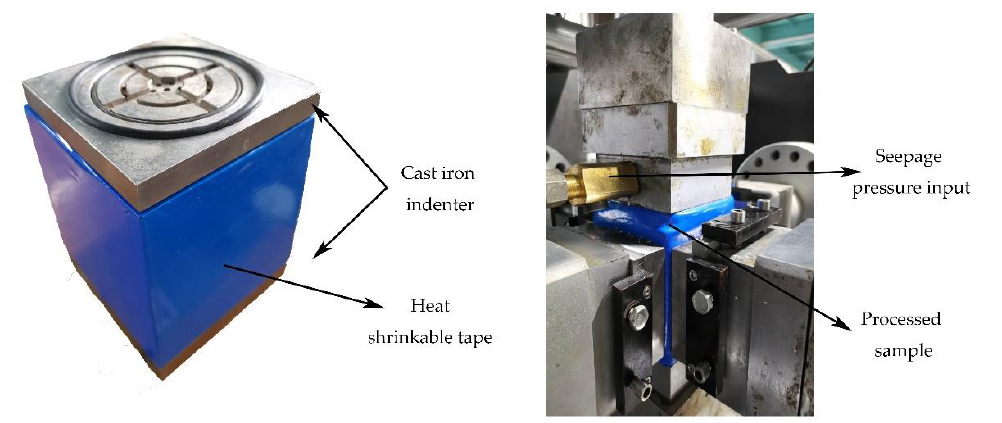
Figure 5. Treatment method of the specimens for unidirectional fissure seepage.